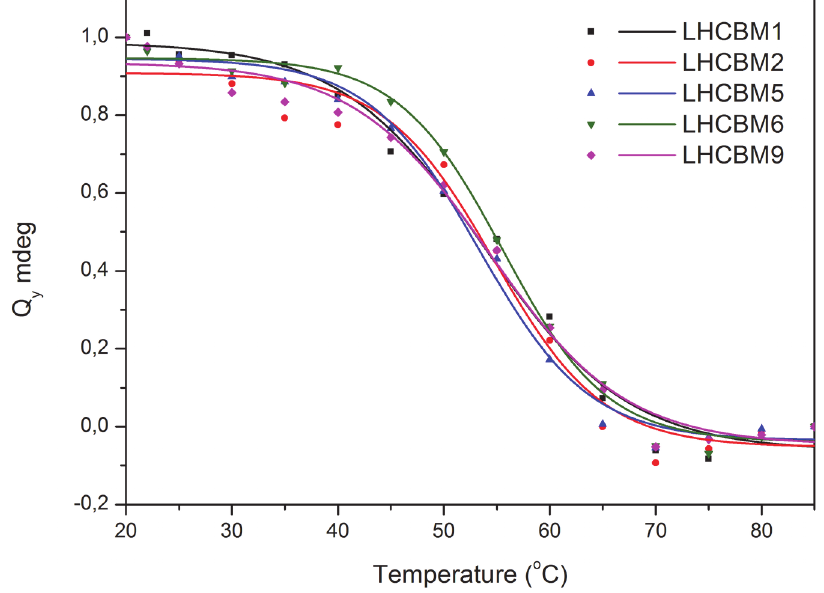
doi:10.1371/journal.pone.0119211.g006